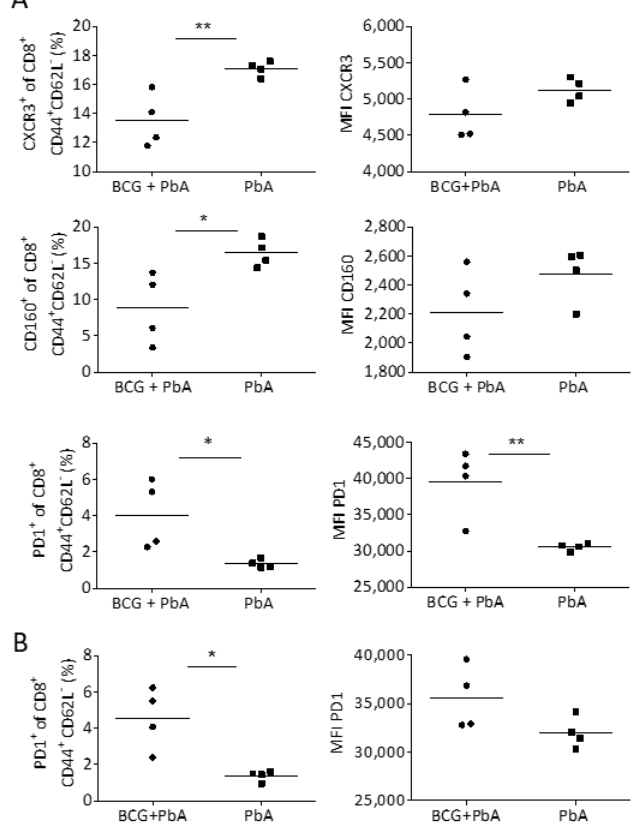
Figure 5. Assessment of CD8 + T cell phenotype in blood and spleen. Flow cytometric assessment of the activation status and surface expression of CXCR3, CD160 or PD1 on CD8 + T cells in blood ( A ) or spleen ( B ) on day 6 after PbA infection in previously naive or BCG-vaccinated mice (n = 4). Symbols and bars represent individual mice and means, respectively. * p ≤ 0.05; ** p ≤ 0.01 determined by Student’s t -test.